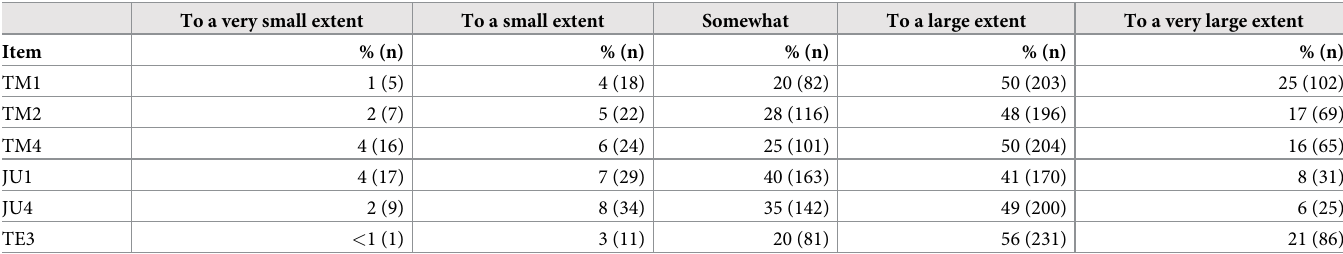
Table 3. Frequency distribution of Workplace Social Capital items of the COPSOQ